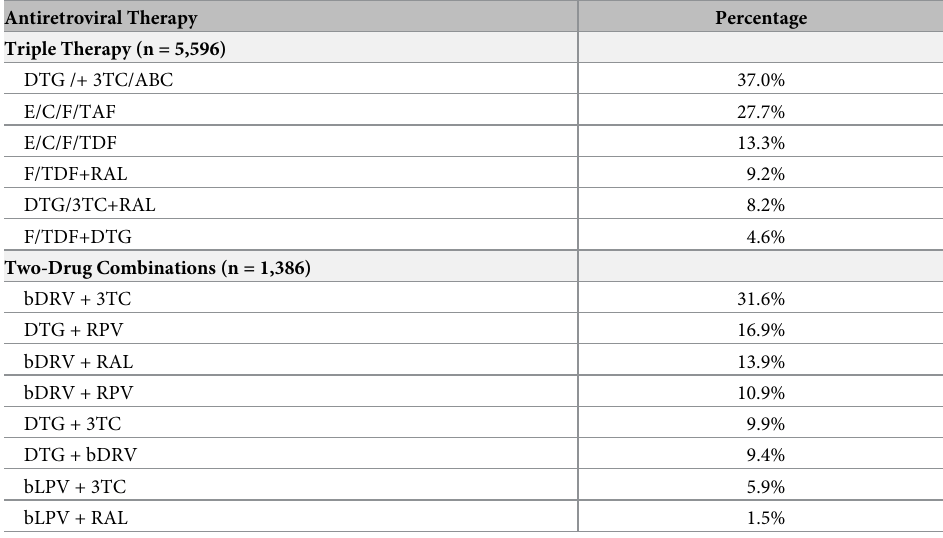
Table 6. Antiretroviral therapy distribution within suppressed at baseline sub-sample, by treatment group. Antiretroviral